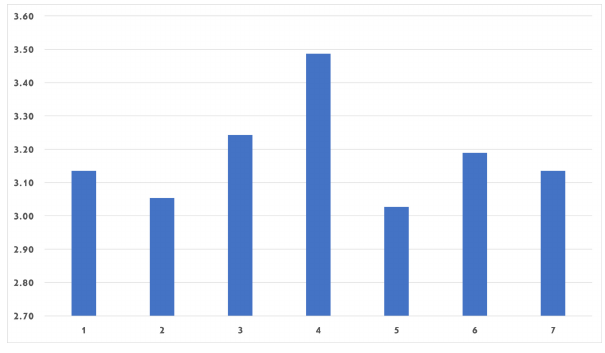
Figure 8. Results of the popularity feedback.